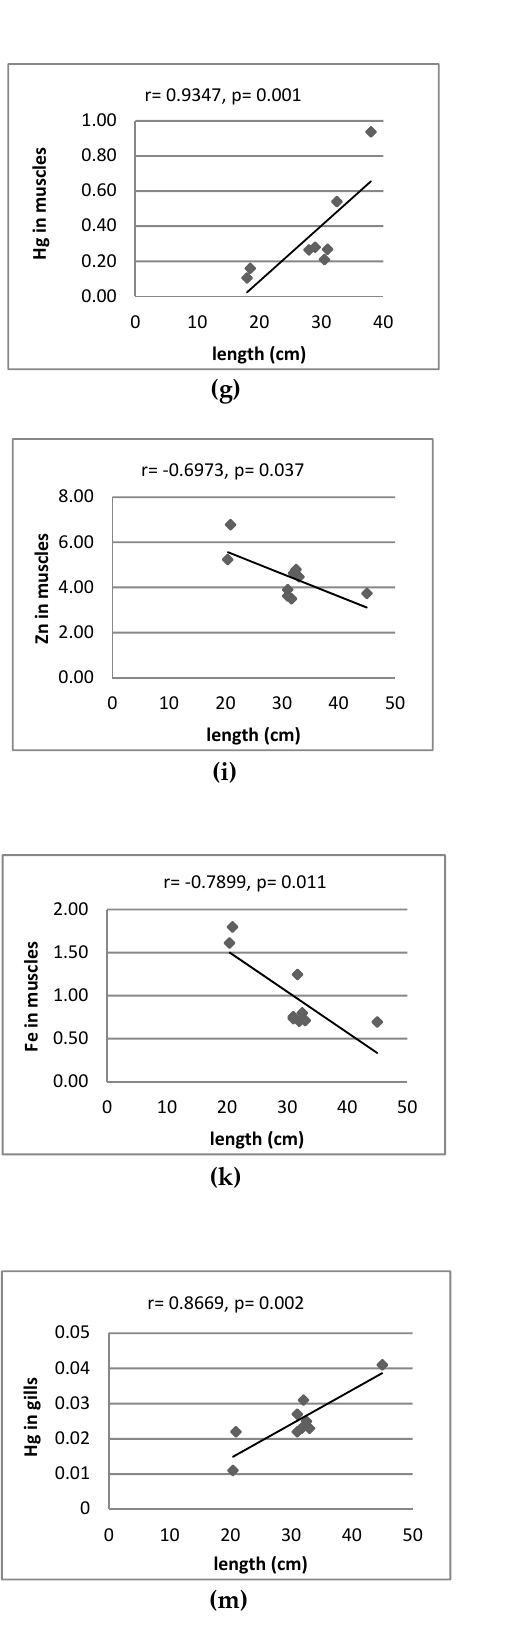
Figure 5. Correlation between contents of metal (mg / kg wet weight) and length of fish. r—correlation coefficients; p —significant level; ( a ) pike, ( b ) pike, ( c ) pike, ( d ) bream, ( e ) bream, ( f ) perch, ( g ) perch, ( h ) perch, ( i ) roach, ( j) roach, ( k ) roach, ( l ) roach, ( m ) roach.